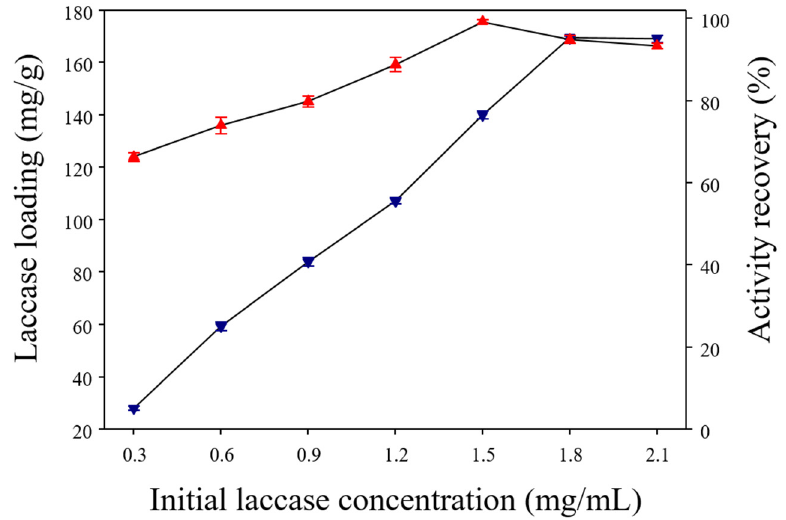
Figure 7. Laccase loading pattern on α -Cellulose-Fe 3 O 4 -CTNs-SH, and laccase activity recovery by α -Cellulose-Fe 3 O 4 -CTNs-SH-Laccase.